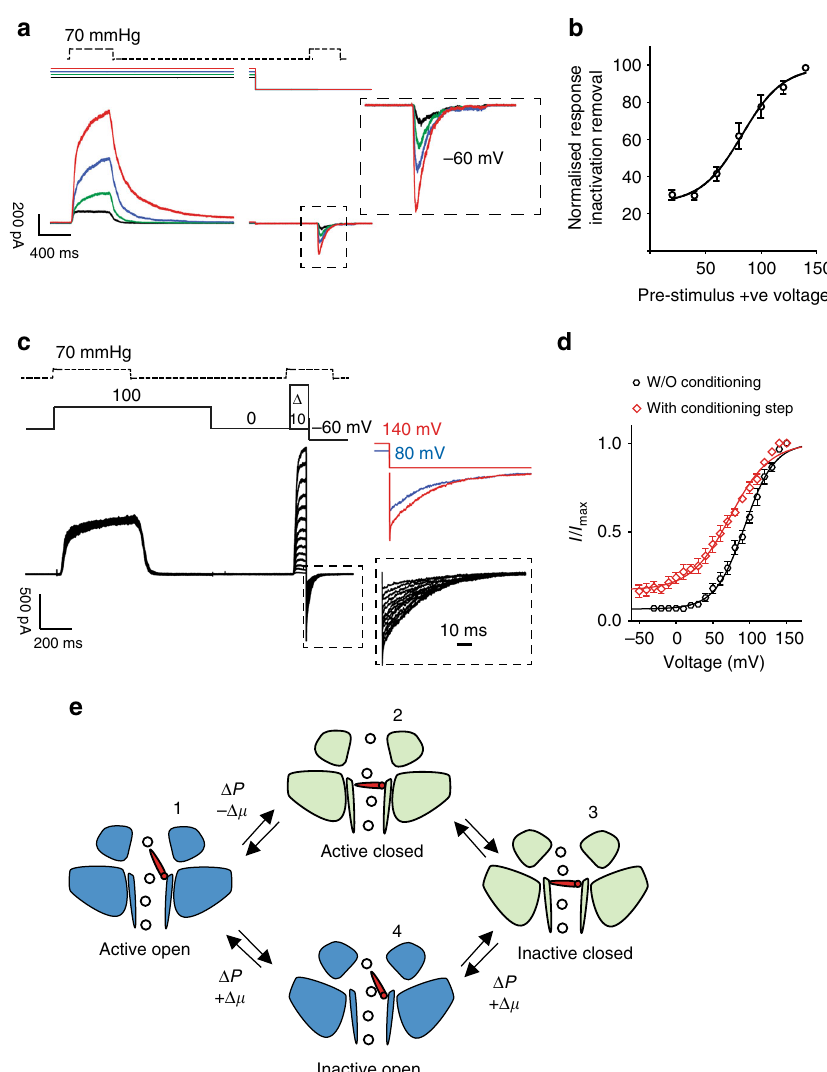
Fig. 3 Increasing outward permeation determines the number of channels available for activation. a A constant pressure pulse at − 60 mV was preceded by a constant pressure stimulation (70 mmHg) at increasing voltages (20 mV black, 40 mV green, 60 mV blue, and 80 mV red). The current amplitude of the second pressure stimulation depends on the driving force applied during the preceding step, showing that the larger the applied driving force the greater the relief from inactivation. b The conditioning stimulus voltage was plotted against the normalized current amplitude of the currents recorded at − 60 mV. Single cells were fi tted individually to a Boltzmann fi t. The data shown represent pooled data from 10 cells ( V 50 = 85.5 ± 5 mV). c Tail current protocol as in Fig. 1d preceded by a conditioning pressure pulse at + 100 mV to remove ~80% of inactivation. d Tail currents from individual cells were normalized to their maximum and fi tted to a Boltzmann relationship ( V 50 = 90.6 ± 2.9 mv, slope 24.6 ± 1.6, n = 12 cells without the conditioning step, black trace, V 50 = 68.3 ± 10.2 mV, slope 43.7 ± 2.3, 5 cells, with conditioning step at + 100 mV, red trace, unpaired Student ’ s t -test P = 0.0036, d F = 15). Pooled data are shown as mean ± SEM. e Proposed transition between active and inactive state PIEZO1. Activation by pressure ( Δ P ) and negative electrochemical gradient ( − Δ μ ) drives the channel into an inactive state (domains tilted upward). Pressure and positive electrochemical gradient ( + Δ μ ) reset the channel to an active state by opening an inactivation gate. The transition 3-4-1 is a slow conformational change as suggested by the rise time and amplitude in Fig. 2j, k,